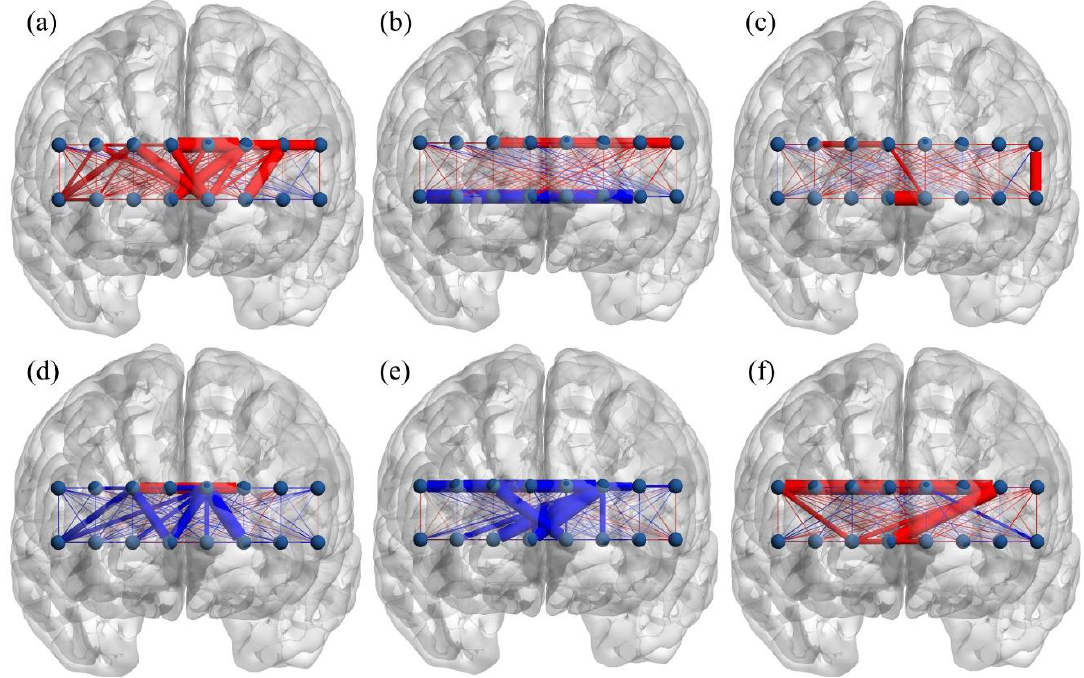
Figure 4. Brain map depicting correlation coefficient between the emotional GNG connectivity and subject performance; ( a – c ) female, ( d – f ) male; ( a , d ) omission error, ( b , e ) commission error, ( c , f ) response time. Red: positive correlation, blue: negative correlation, thick edge: connection with significant correlation coefficient ( p -value < 0.05).